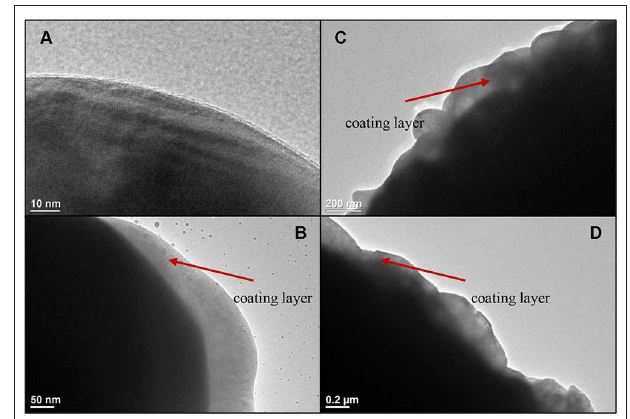
FIGURE 4 | TEM images of NCM811 samples ( A -uncoated, B -Coated by Al 2 O 3 , C -Coated by ZrO 2 , D -Coated by LBO).